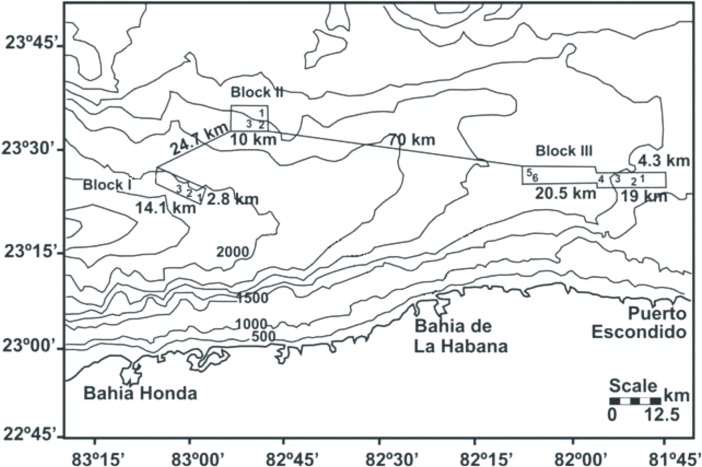
Bathymetry.Bathymetry of the NW slope of Cuba, Southern Florida Straits. The explored Blocks I, II and III are indicated from left to right, including their dimension, the location of the 12 sites sampled in the Blocks and the distance between them (modified from CESIGMA, 2002).